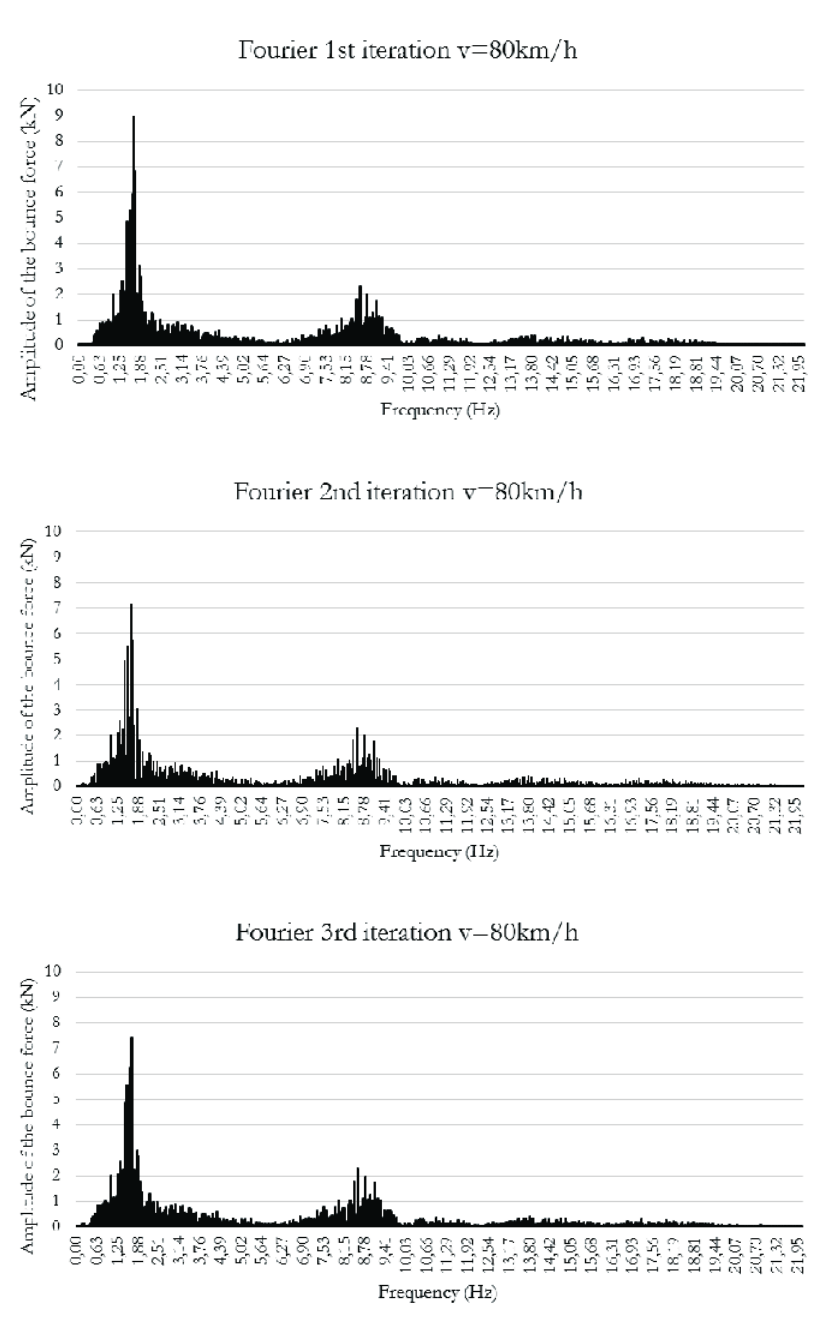
Fourier analysis of bounce forces F